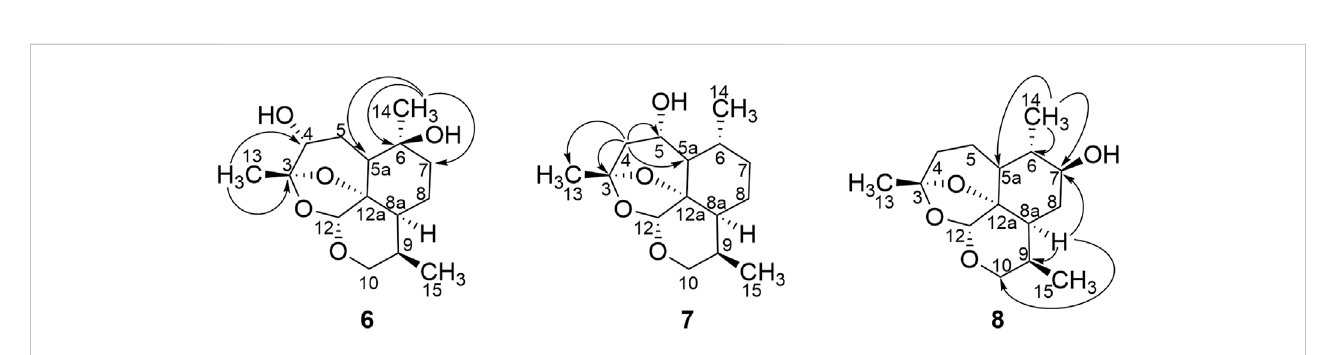
FIGURE 3 HMBC correlations for compounds 6, 7, and 8.